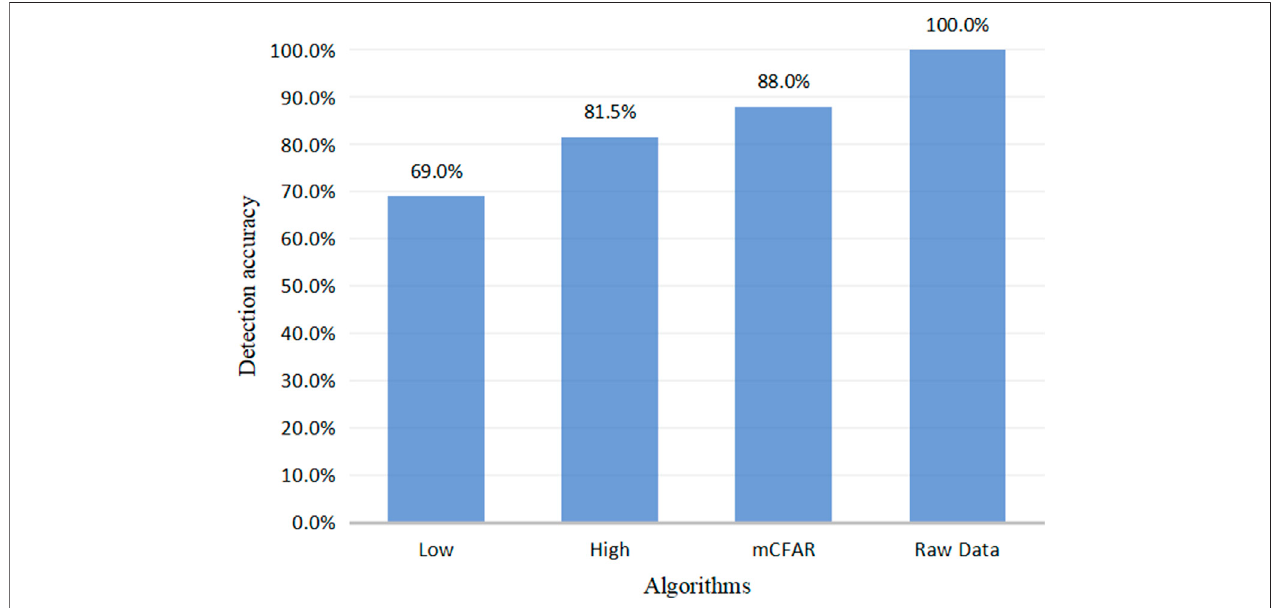
FIGURE 7 | Performance of three segment detection methods.